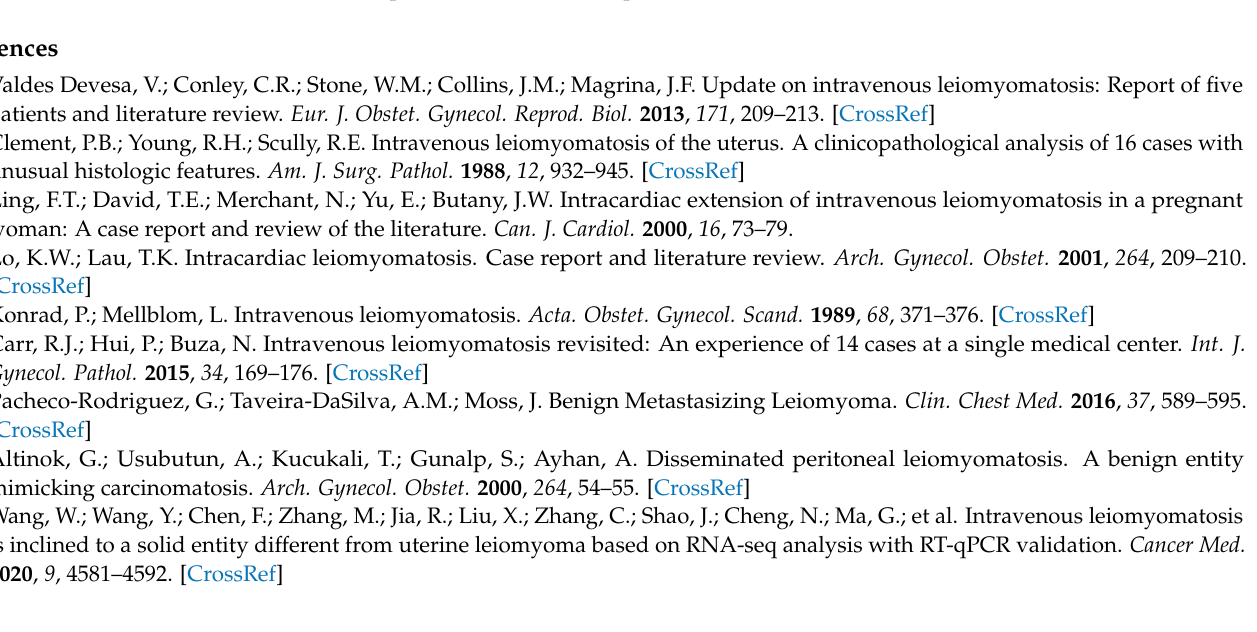
cohort. Figure S2: Comparative analysis of expression levels of SRSF3 protein by SWATH-MS with immunohistochemical staining (IHC) of the FFPE tissue sections from the same samples in the cohort. The line and whiskers in plots for SWATH-MS represent median and interquartile range. Stacked bar charts for IHC represents immunoreactivity of individual samples. Photomicrographs of representative samples with strong, weak and no staining for SRSF3 protein are shown. Scale bar represents 50 µ m. Table S1: Full proteomic dataset for the cohort. Table S2: List of splicing factors found in the three individual consensus